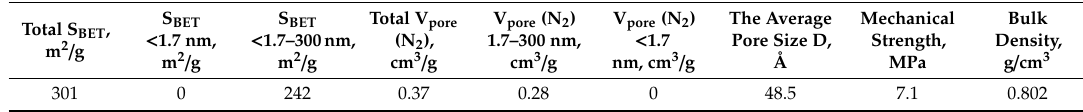
Table 8. Physico-chemical properties of Al 2 O